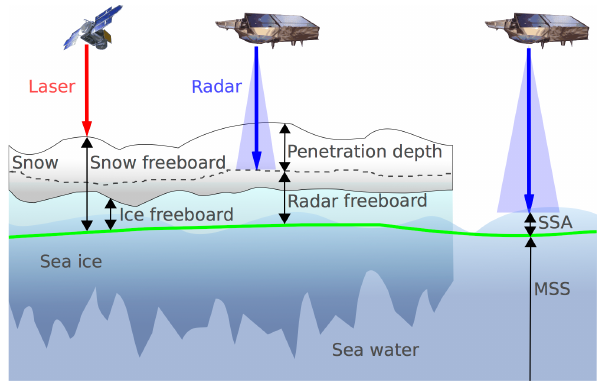
Figure 2. Flowchart of the CryoSat-2 data processing